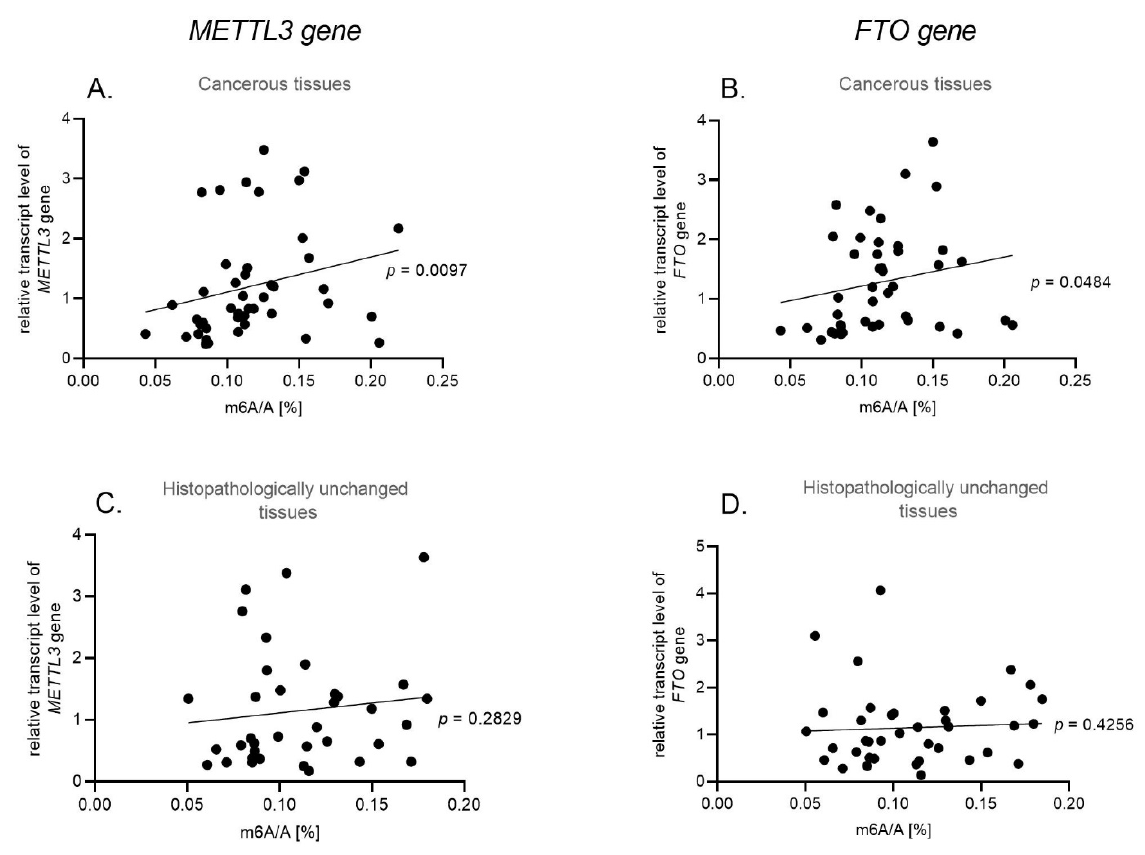
Figure 3. Spearman correlation of m 6 A/A [%] and METTL3 and FTO mRNA level in cancerous tissues ( A , B ) and histopathologically unchanged tissues ( C , D ).